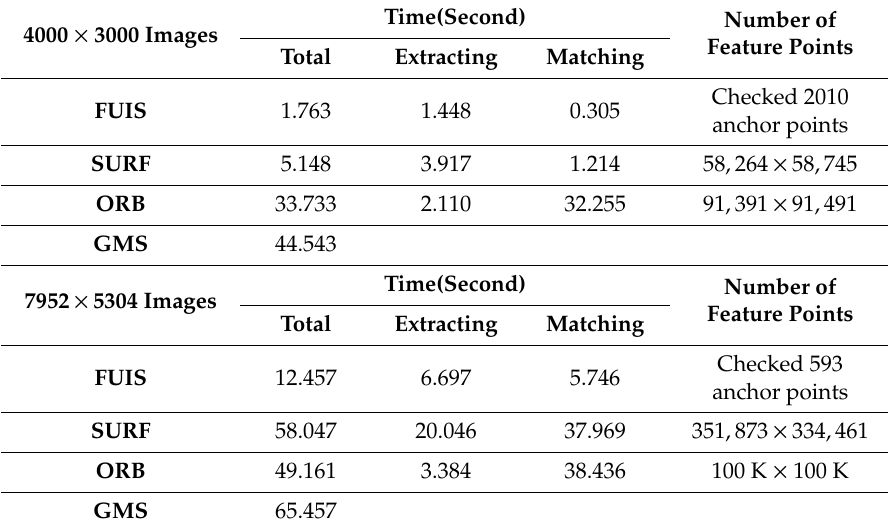
Table 1. Computational complexity of di ff erent